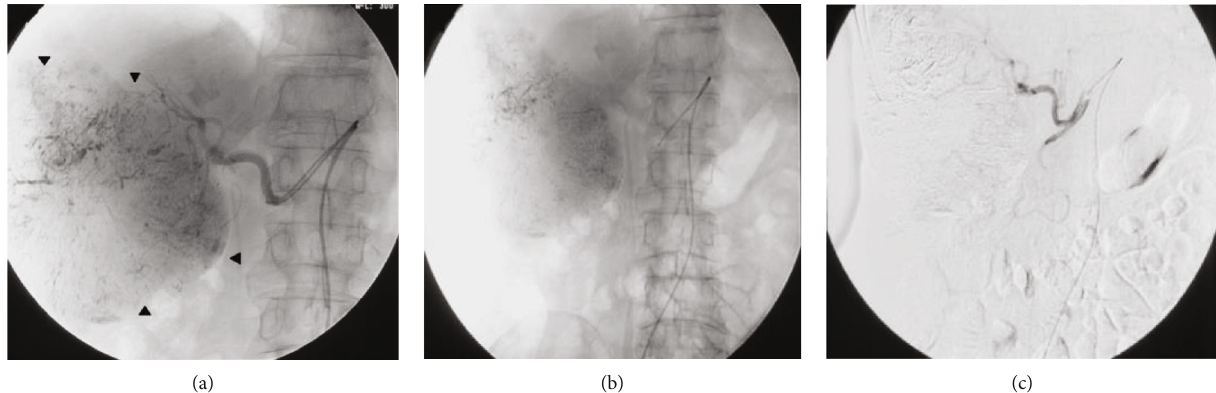
Figure 3: (a) Hepatic arteriogram shows a large tumor staining in the right hepatic lobe (arrowheads). (b, c) Arteriogram after chemoembolization of the tumor, and its feeding branch shows no residual tumor enhancement.